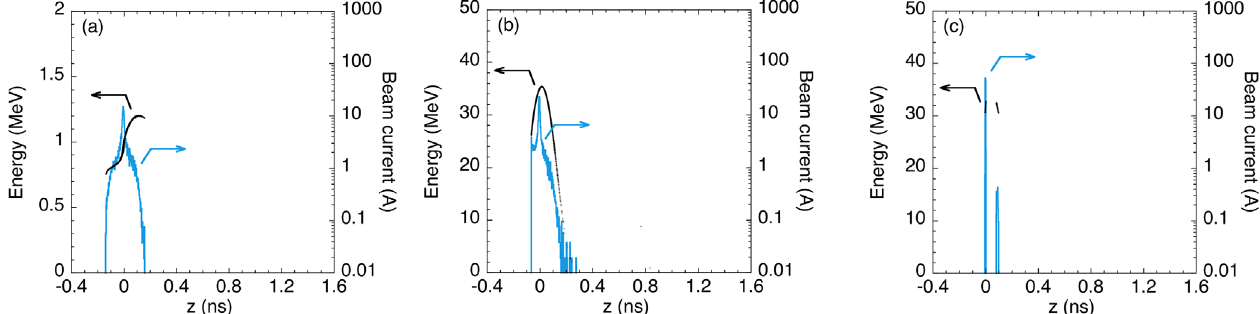
FIG. 6. Energy profile (black dots) and beam current (blue line) as functions of the bunch longitudinal position (time) for the SACLA injector simulated using PARMELA. (a), (b), and (c) correspond to the L-band structure entrance and exit and after the BC1 energy slit,